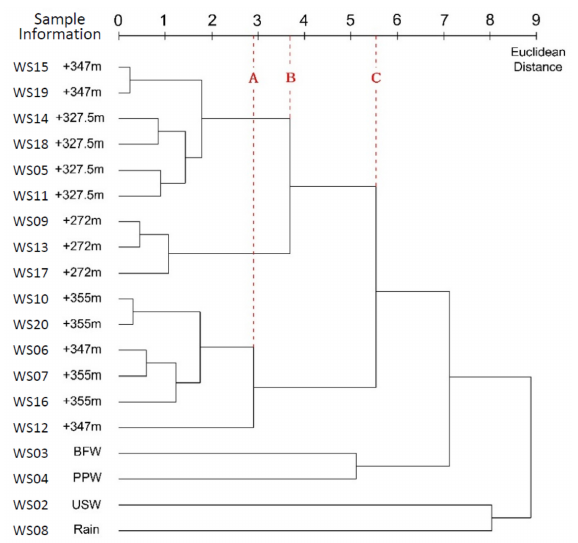
Figure 8. Dendrogram of data through complete-linkage clustering.